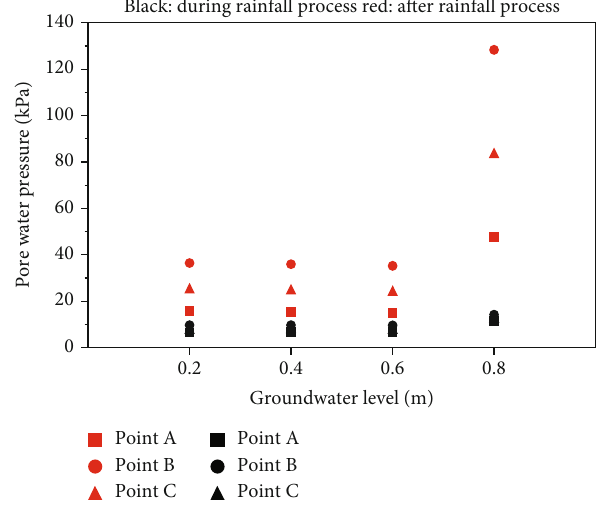
Table 2: Parameters of the vegetated